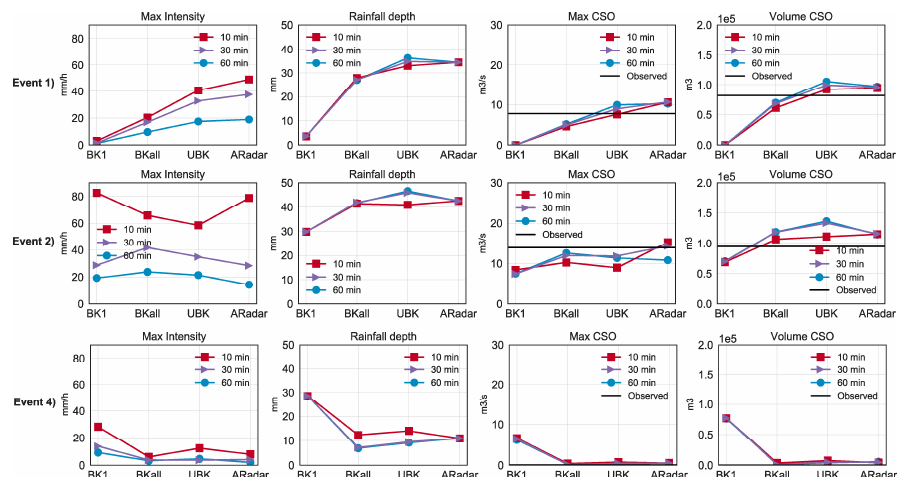
Figure 5. Rainfall input and urban drainage response for the municipality of Valkenswaard. Each graph depicts the effect of the four rainfall products rendered at different time accumulation steps. From left to right; maximum rainfall intensity, accumulated rainfall depth, maximum CSO flow and accumulated CSO volume.